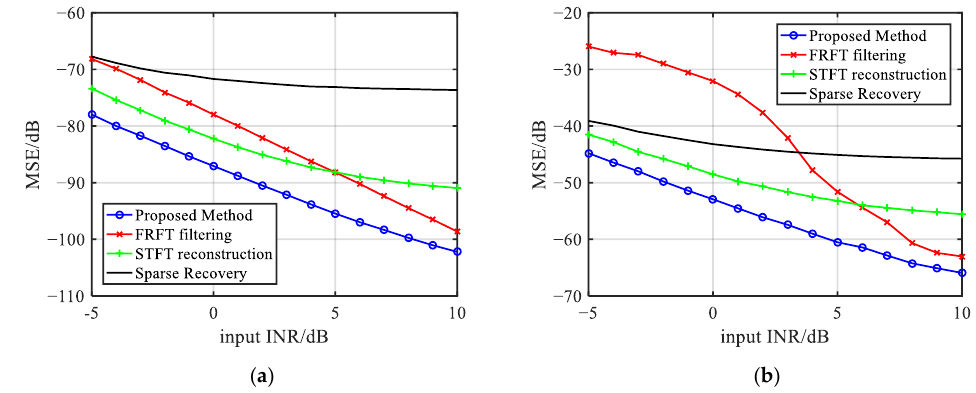
Figure 11. Comparison of jamming reconstruction MSE of the proposed method with other meth- ods. ( a ) ISRJ reconstruction; ( b ) SMSP jamming reconstruction. ( a ) ISRJ reconstruction; ( b ) SMSP jamming